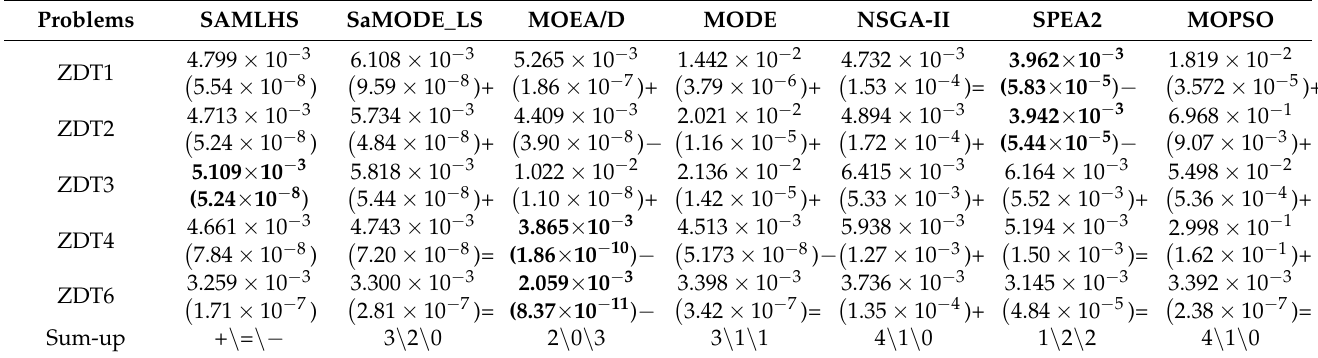
Table 4. Comparison of the IGD measure between SAMLHS and other MOEAs, mean